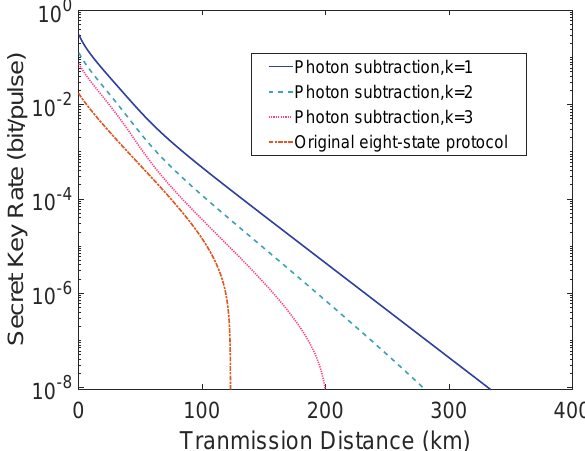
Figure 4. Performance of eight-state protocol with a photon subtraction operation. Here, (cid:101) = 0.001 and β = 0.95. The orange line is for the original eight-state protocol and the other lines are for the photon subtraction with k ∈ { 1,2,3 } , respectively.